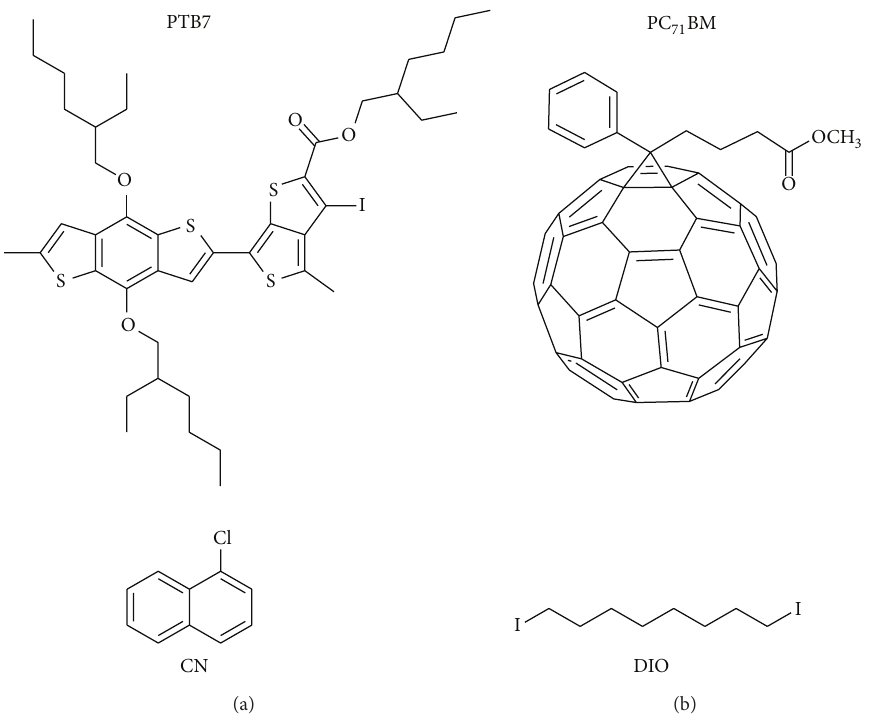
Figure 1: Molecular structures of PTB7, PC 71 BM, CN, and